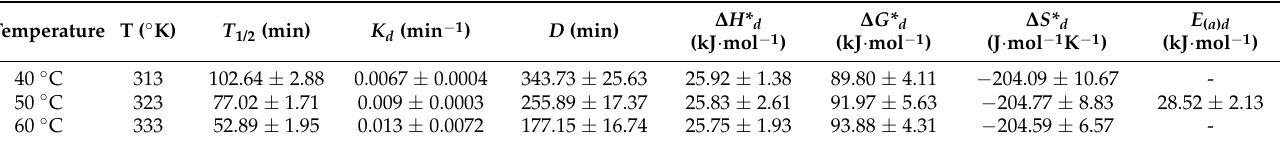
Table 3. Thermodynamic parameters for irreversible inactivation of the S. xylosus A2